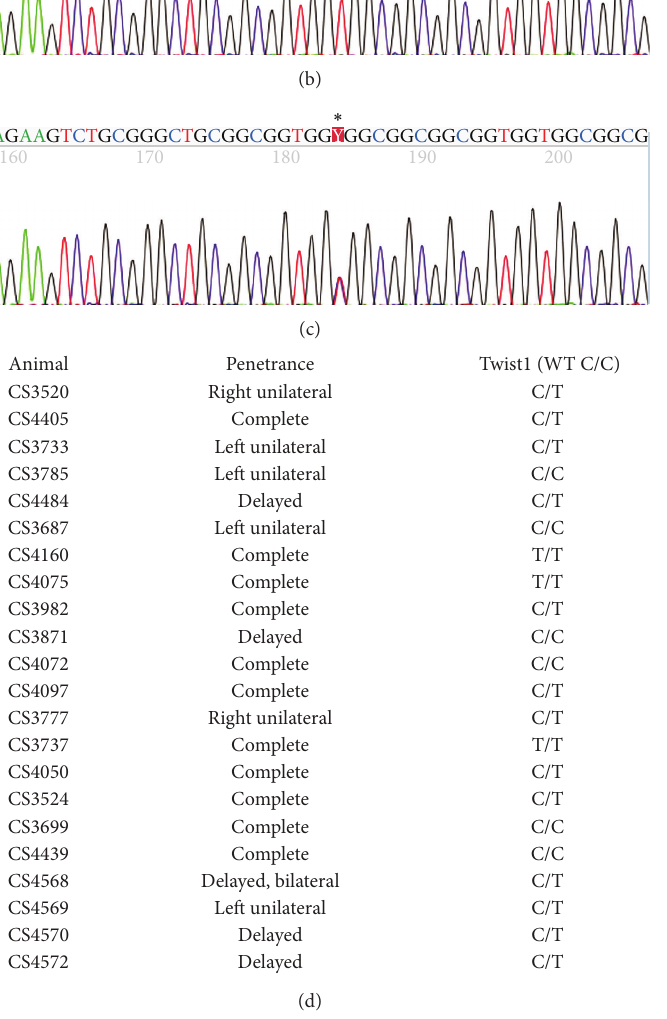
Figure 2: SNP discovery and genotyping of Twist1 in craniosynostotic rabbits. We identified a SNP within the Twist1 coding region, a silent mutation, that segregates independently of craniosynostosis within our colony, ruling out Twist1 as the causative agent. ((a)–(c)) Sequencing traces representing C/C (a), T/T (b), or C/T (c) genotypes from PCR using CS genomic DNA. (d) Results of sequencing 22 randomly selected CS animals; six animals were C/C genotype, three animals were T/T, and 13 animals were